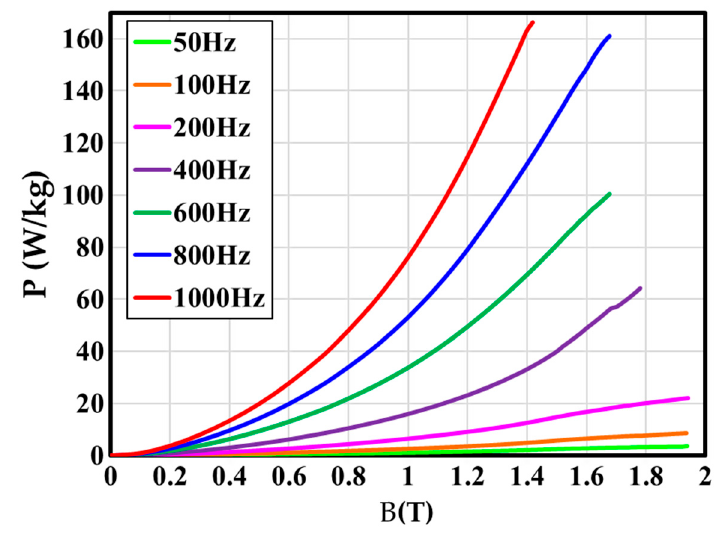
Figure 2. Iron loss with the magnetic flux density at different frequencies.